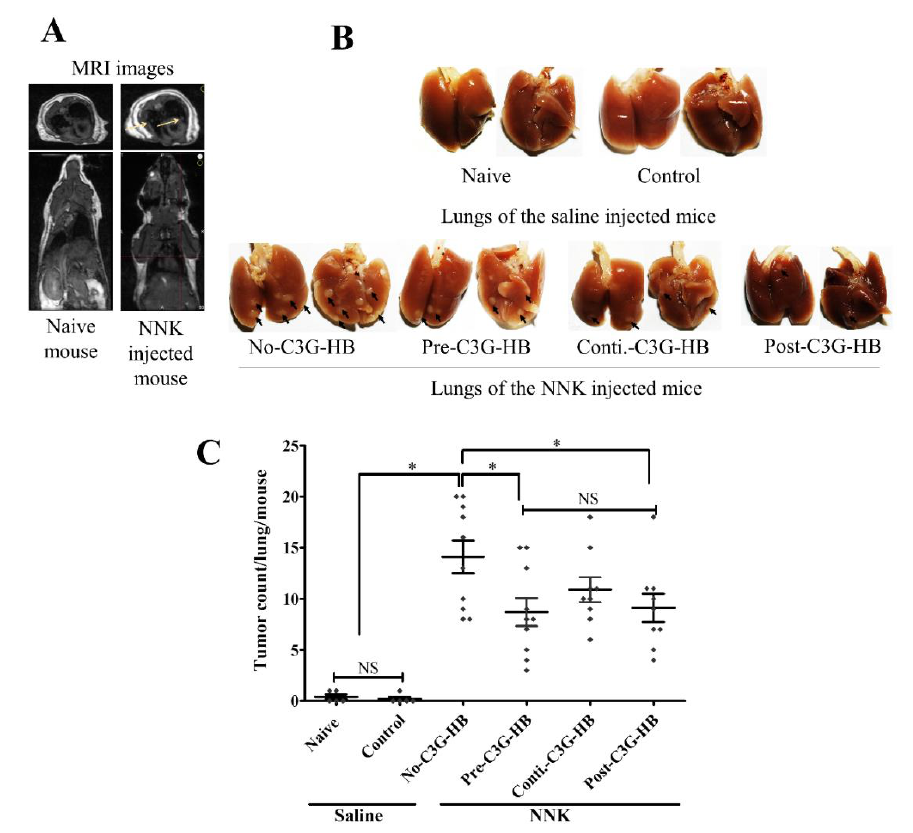
Figure 2. The e ff ect of C3G-rich haskap berry supplement (C3G-HB) on NNK-induced lung tumorigenesis in A / JCr mice. Saline was injected as a sham for mice in naive and control groups. A single intraperitoneal injection of NNK (100 mg / kg body weight) was used to induce lung tumors in the rest of the mouse groups (pre-C3G-HB, conti.-C3G-HB, and post-C3G-HB). Naive mice were fed a regular mouse diet. Mice in control and NNK-injected groups were fed the C3G-HB supplemented diet, as presented in Figure 5. ( A ) The presence of lung tumors was confirmed by PET / MRI scan and a representative comparison between naive and no-C3G-HB groups ( n = 3). ( B ) The number of peripheral tumors was counted in each lung under a dissecting microscope ( n = 5 for naive and control groups, and n = 10 for NNK-injected groups). ( C ) The e ff ect of C3G-HB dietary supplement on lung tumor multiplicity was analyzed by one-way ANOVA with Dunnett’s test at α = 0.05. No-C3G-HB, not given C3G-HB supplemented diet; Pre-C3G-HB, C3G-HB supplemented diet only before NNK injection; Conti.-C3G-HB, C3G-HB supplemented diet continuously before and after NNK injection; Post-C3G-HB, C3G-HB supplemented diet only after NNK injection. * Indicate statistical di ff erence at p ≤ 0 05 with mean ± SD. NS, Results do not significantly di ff